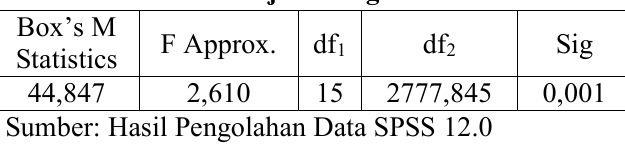
Tabel 7. Hasil Uji Homogenitas Varians Box’s